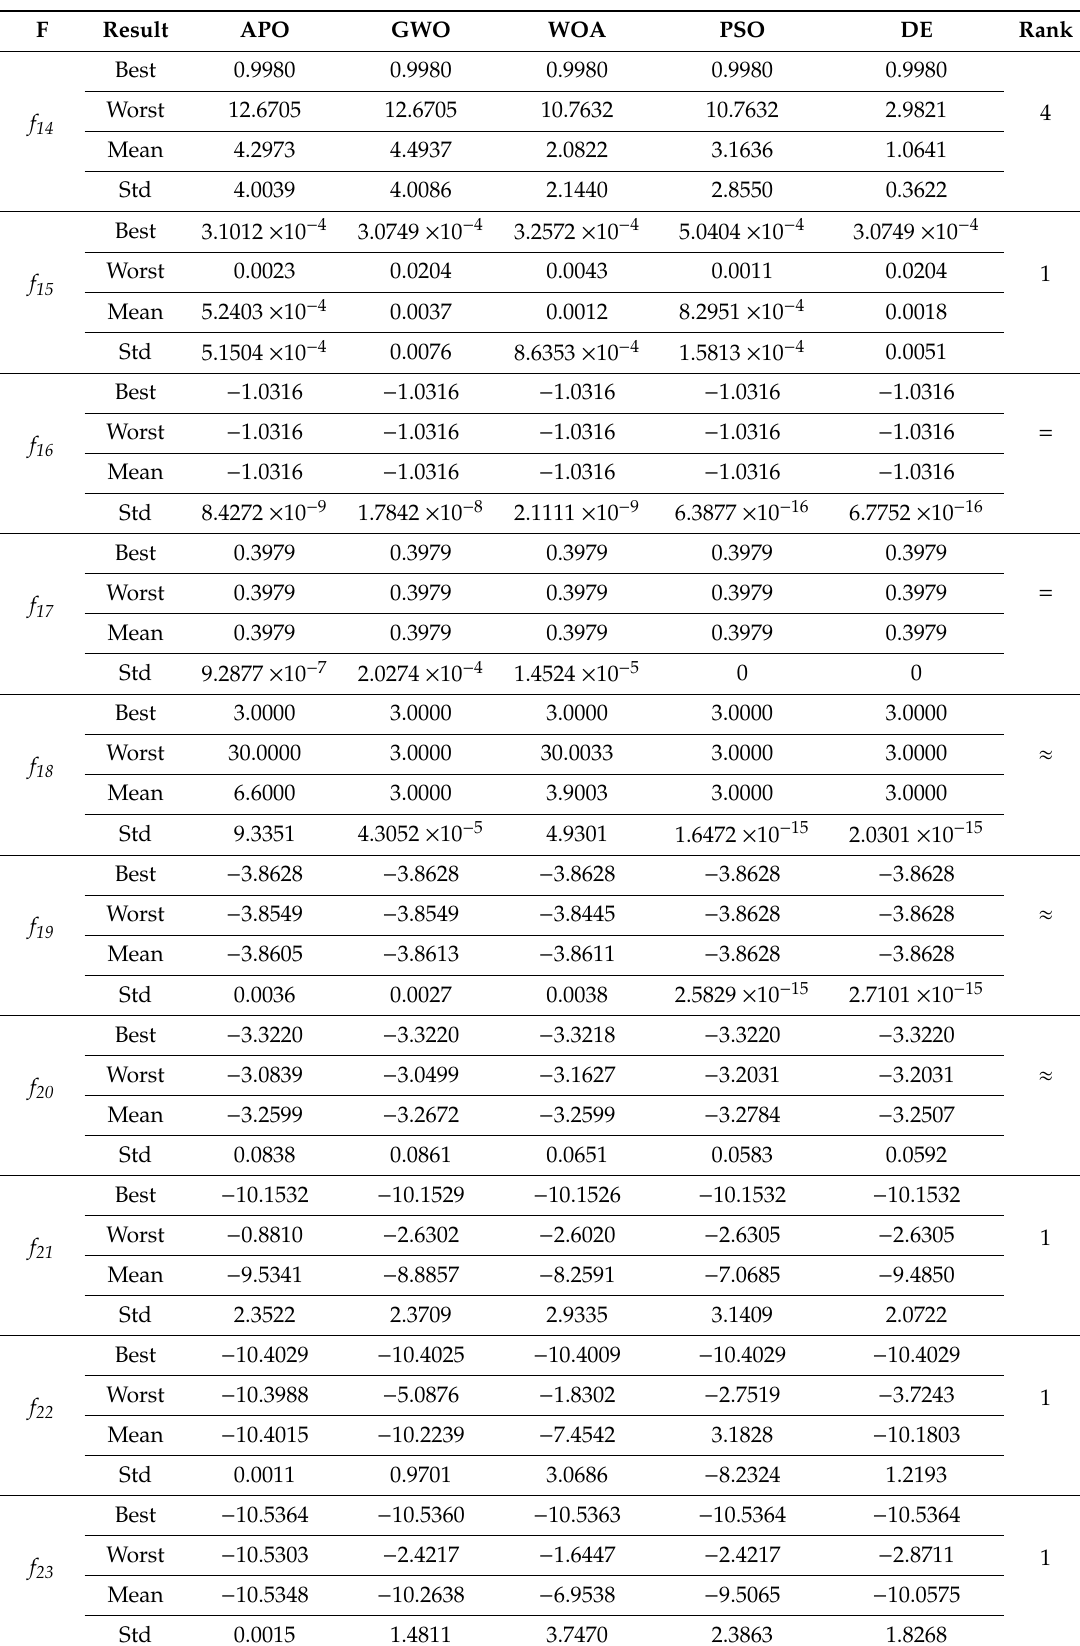
Table 6. Best, worst, wean, and SD obtained on functions from Table